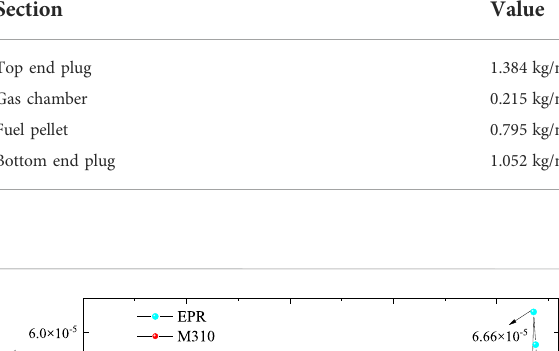
TABLE 6 Linear density of fuel rods.